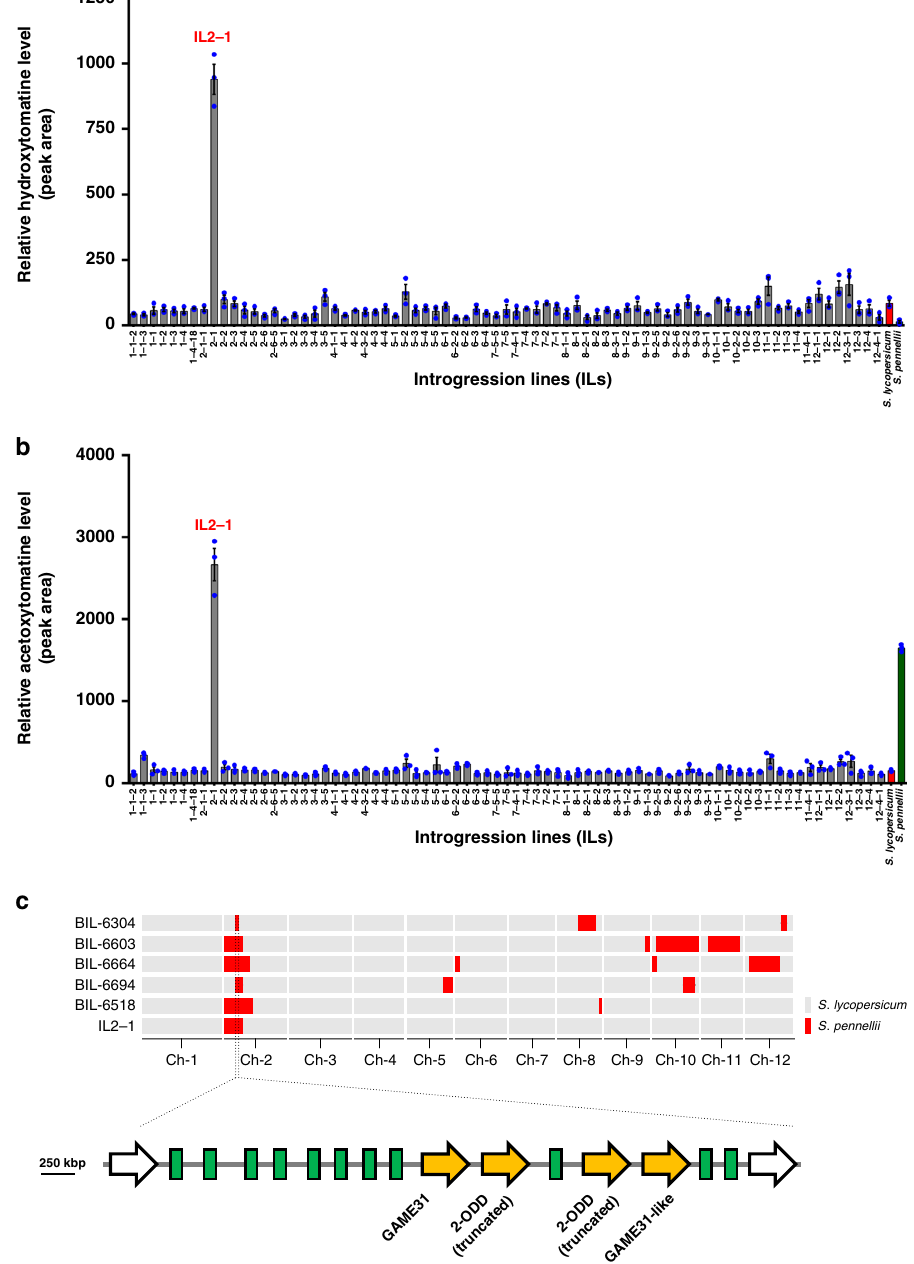
Fig. 3 Discovery of the GAME31 candidate gene in hydroxytomatine-associated QTL region on tomato chromosome 2. a , b Hydroxytomatine ( a ) and acetoxytomatine ( b ) levels in 77 core IL population including parental lines. SGA content was determined from ground leaf tissue extracts ( n = 3). The values represent the means of three biological replicates ± standard error mean ( n = 3). LC-MS was used for targeted SGAs analysis. c Schematic representation of chromosomal regions in selected BILs (i.e. #6304, #6603, #6664, #6694, #6518) and the IL2-1 line carrying introgressions from the wild species S. pennellii . An overlapping QTL (between selected BILs and IL2-1 line) region located on chromosome 2 affecting the content of hydroxytomatine and acetoxytomatine revealed 17 annotated genes. A putative candidate gene termed GAME31 belonging to the 2-oxoglutarate dependent dioxygenase (2-ODD) family is depicted with a yellow block arrow along with three other 2-ODDs in the region. The remaining 11 genes are marked in green color, while the fi rst and last genes in the region are shown with a white block arrow. Details regarding these 17 genes are provided in Supplementary Data 2. The source data of Figs. 3a and 3b are provided as a Source Data fi